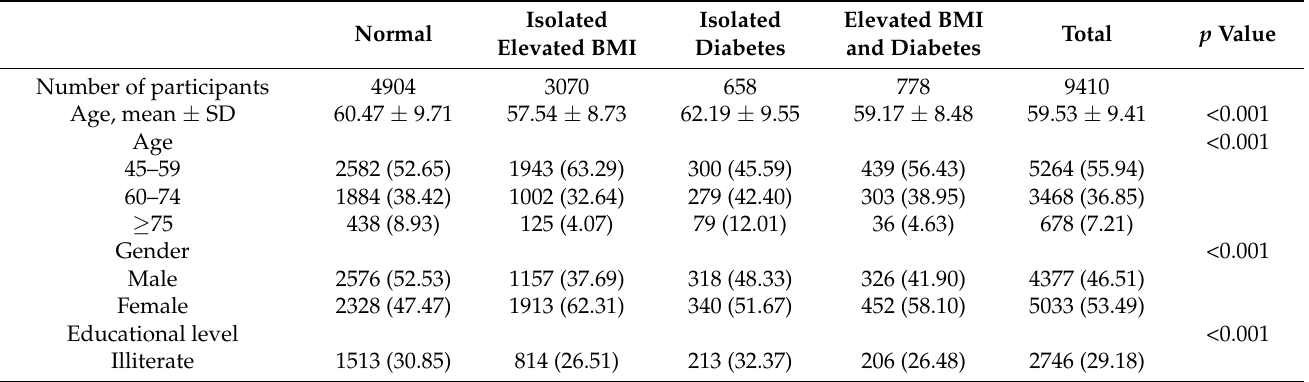
Table 2. Baseline characteristics of the study population of Chinese adults and the presence of elevated BMI 1 , diabetes 2 , or